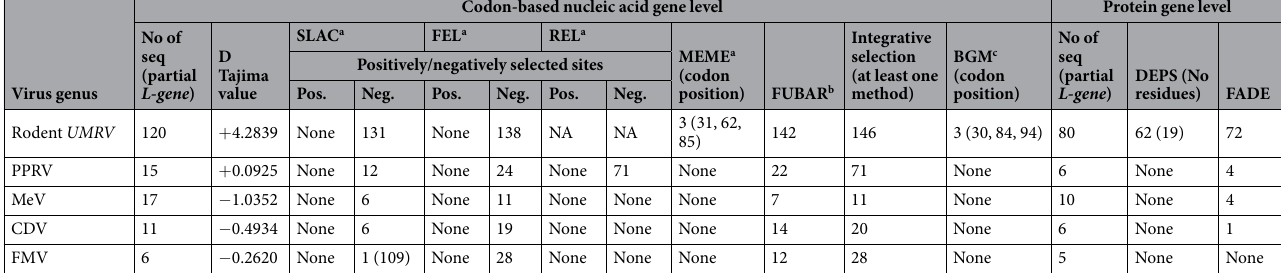
Table 2. Summary of selection pressures acting in Rodentia UMRV versus Morbilliviruses. a p < 0.1 (no positively selected sites were detected, except for one site (62) with MEME at p < 0.05). b Posterior probability > 0.90. c Posterior probability > 0.95. seq: sequences. For nucleic acid level, we used the HKY85 model, except for Rod- UMRV (GTR) with input neighbor-joining trees. For protein gene level, we used the JTT model. Directional Evolution Protein Sequences (DEPS) in UMRV (selective sweeps): 23 residues substitutions evolving under a Frequency-dependent selection, 73 residues substitutions evolving under a Convergent evolution and 18 sites evolving under a Balancing selection (Frequency-dependent selection versus Convergent evolution).